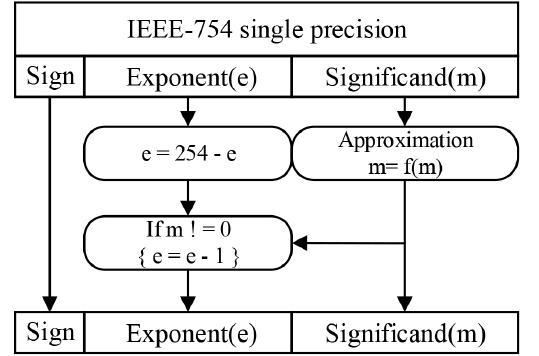
Figure 5. Block diagram of the reciprocal